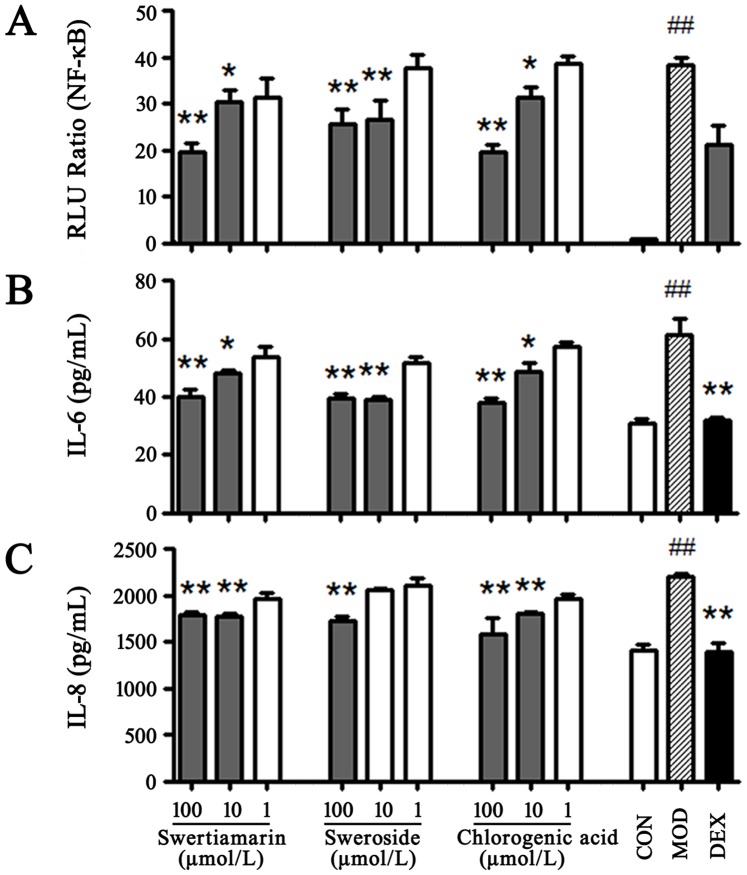
Confirmation of the effects by potential NF-κB inhibitors.A: Effects of the potential NF-κB inhibitors on the NF-κB expression. B and C: IL-6 and IL-8 expression in TNF-α induced BEAS-2B cells, respectively. Each bar represents the mean ± SEM; n = 6 for each group. One (*) or two (**) indicate p<0.05 or p<0.01 vs the TNF-α treated group, respectively; ## indicates p<0.01 vs the control group.